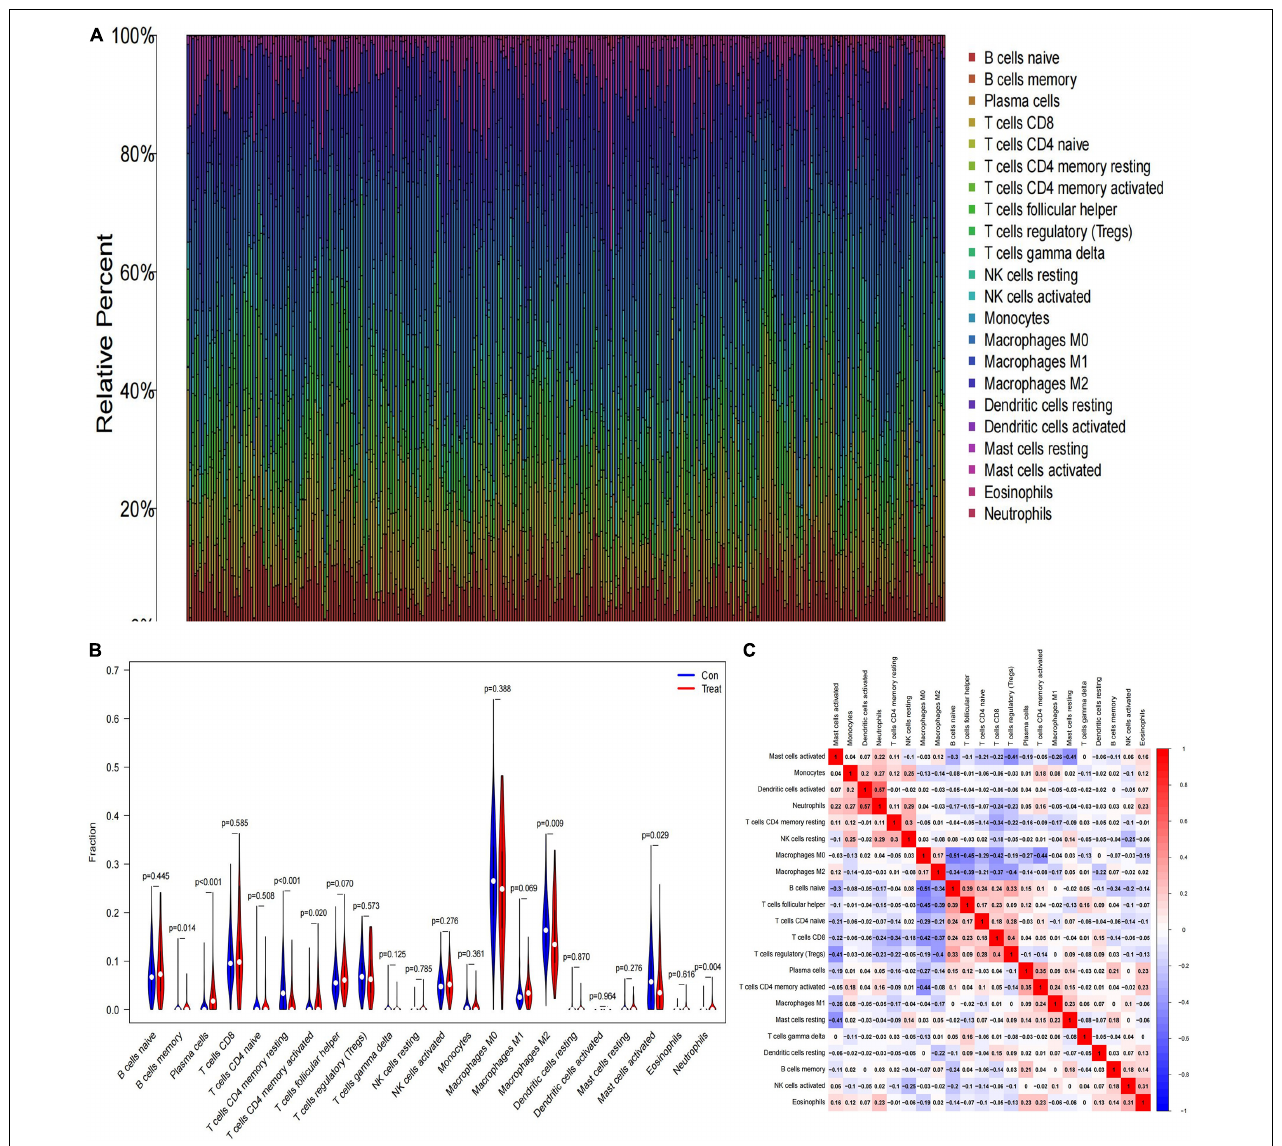
FIGURE 4 | The landscape of immune infiltration between low- and high-risk category groups. (A) The relative percentage of 22 subpopulations of immune cells in the training cohort; (B) the difference in immune infiltration between low- and high-risk category groups. (The low-risk category group was marked as blue color and the high-risk category group was marked as red color; p -values < 0.05 were considered as statistically significant.); (C) The correlation of 22 subpopulations of immune cells. Red represents positive correlation; blue represents negative